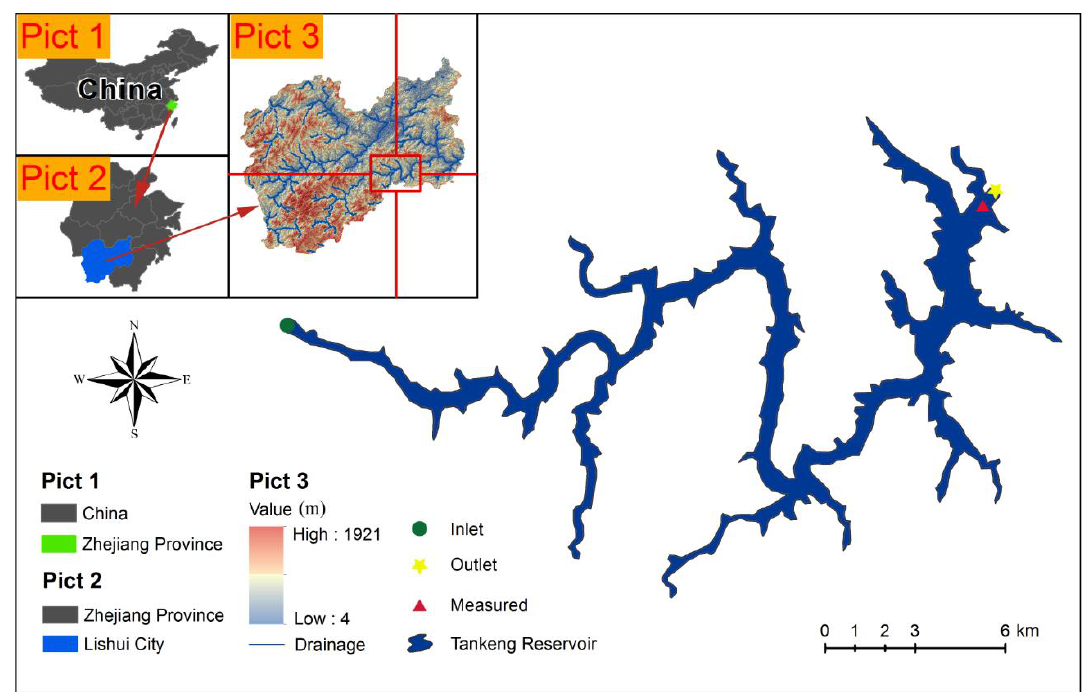
Figure 1. The geographic location of the Tankeng Reservoir. Pict 1, Pict 2 and Pict 3 show the location of the Tankeng Reservoir. The blue represents the water surface at the elevation of 160 m. The yellow star is the basin outlet within the dam. The green dot is the basin inlet 52 km away from the dam. The red triangle indicates the location of the measurement station, 1 km away from the dam.